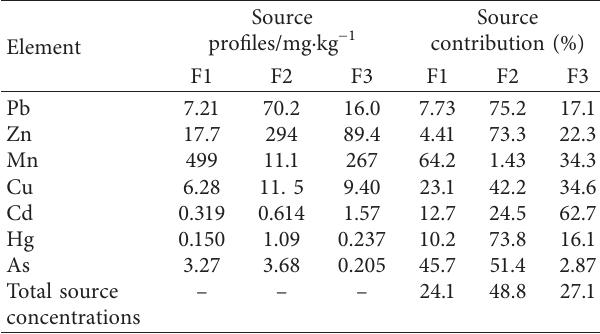
Figure 5: Apportioned results obtained from PMF model. Table 2: Contribution rates of factors to HMs in the sediments around this lead-zinc